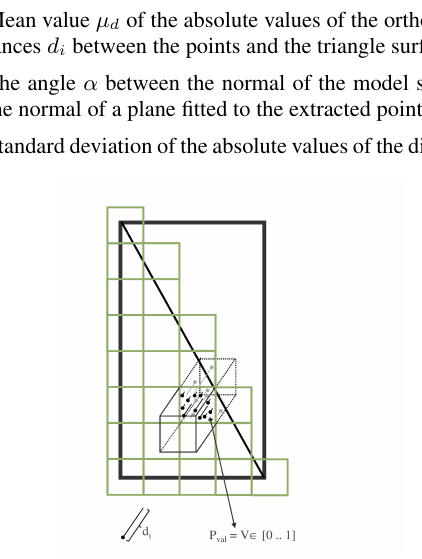
Figure 4. Usage of the raster cells introduced in Figure 1 for calculation of the measure P val . The measure is based on the orthogonal distance d i of the points within the bounding